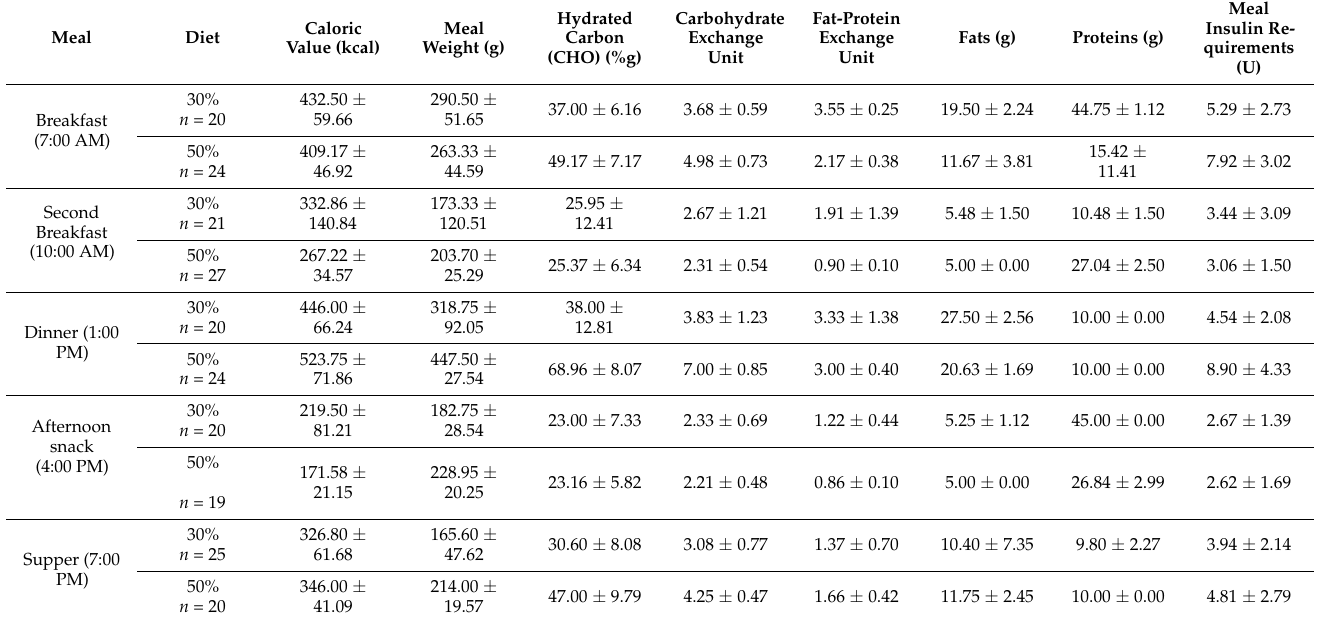
Table 1. Meal and insulin-therapy related factors for meals analysis ( n = 220 records). Values are provided as % and number of cases or mean ± standard